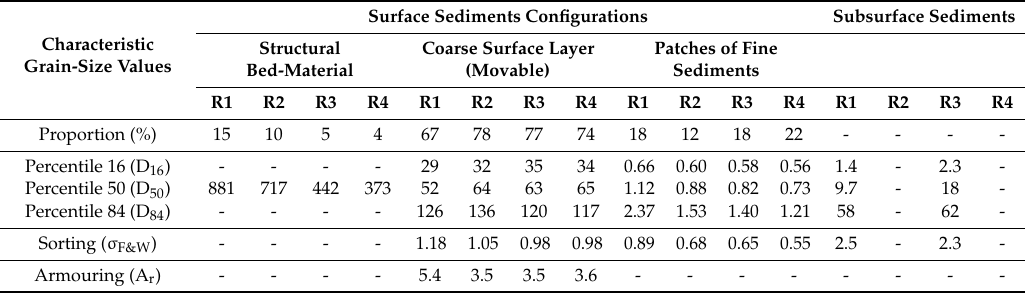
Table 1. Characteristic grain-size values of the various sedimentary fractions of the river-bed (see Section 3.3 for methodological